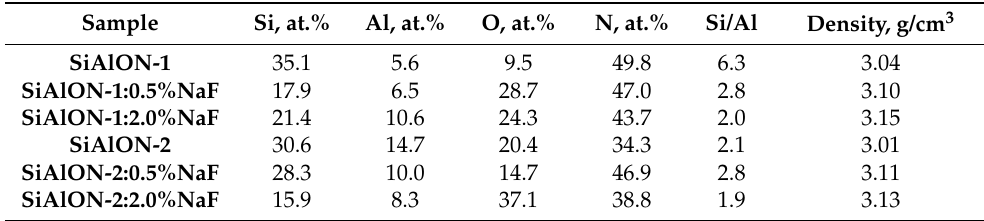
Table 3. Average content of elements in the studied materials according to EDX spectroscopy and their densities measured by hydrostatic weighing.